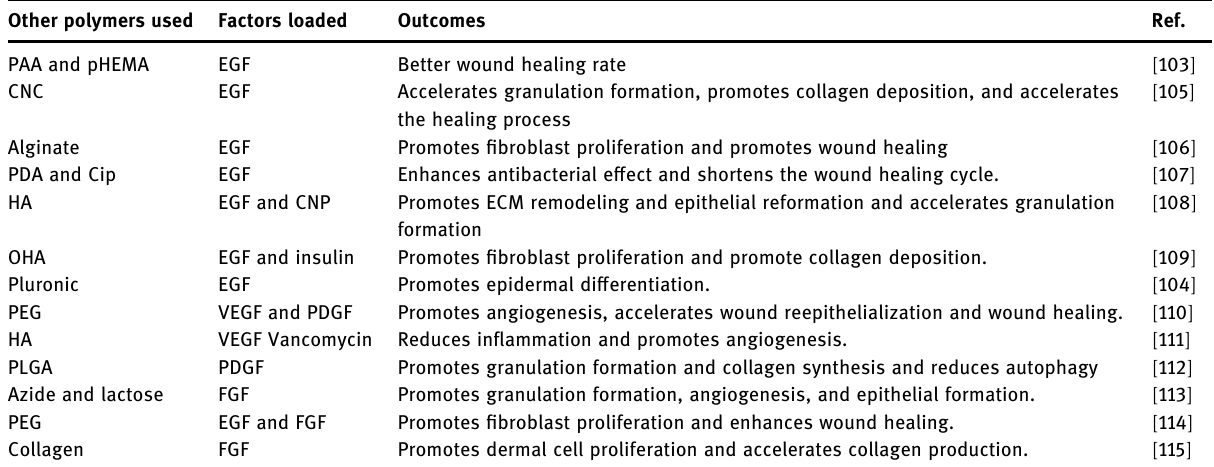
Table 2: Summary of chitosan hydrogel loaded with growth factors in wound healing Other polymers used Factors loaded